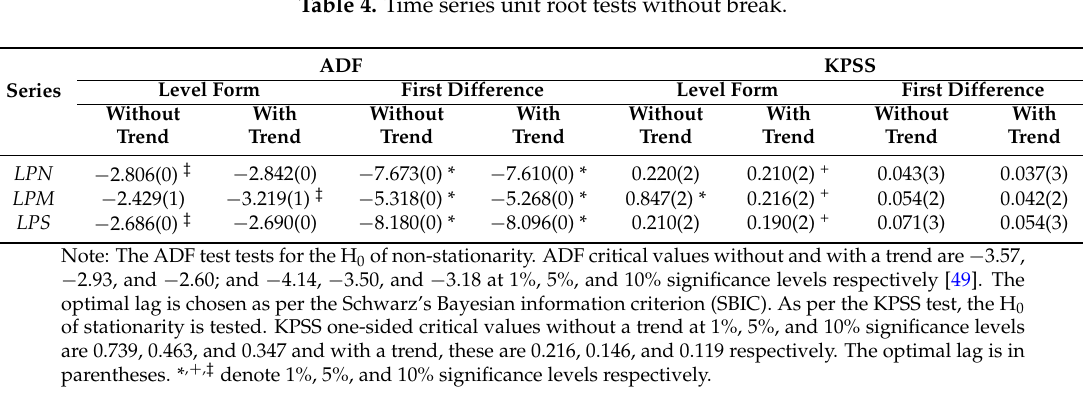
Table 4. Time series unit root tests without